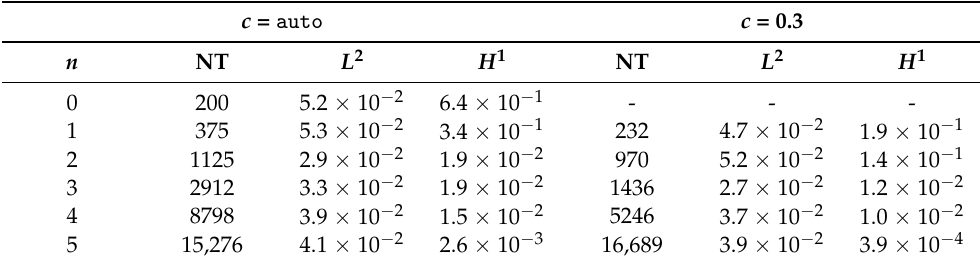
Table 10. Error in L 2 norm and H 1 seminorm for example 4 obtained with the residual-based error estimator.